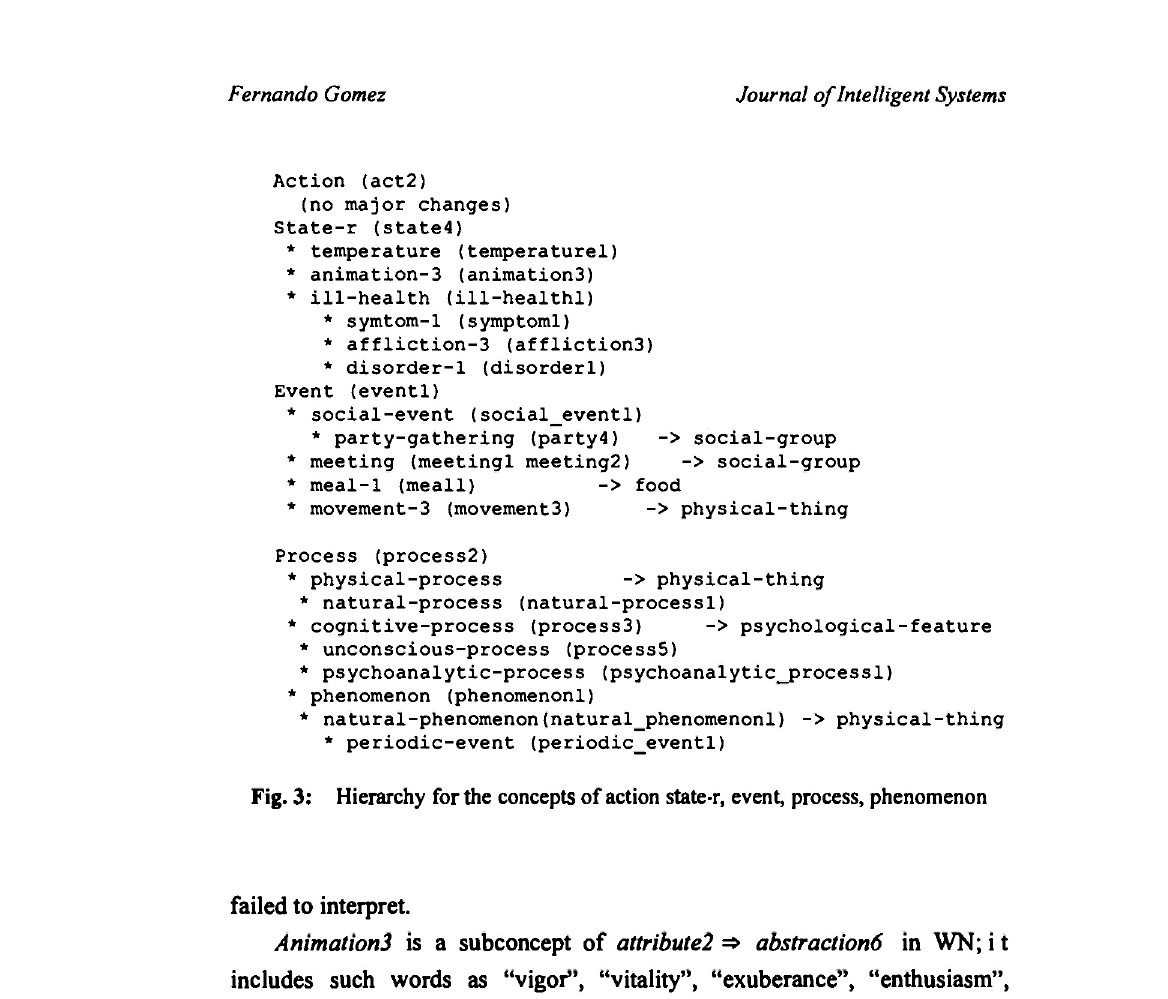
failed to interpret. Animation3 is a subconcept of attribute2 abstractionö in WN; i